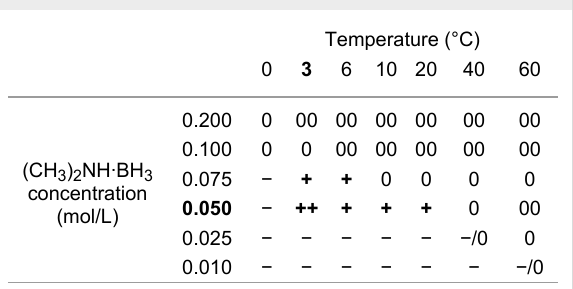
Table 3: ITO deposition under various conditions at pH